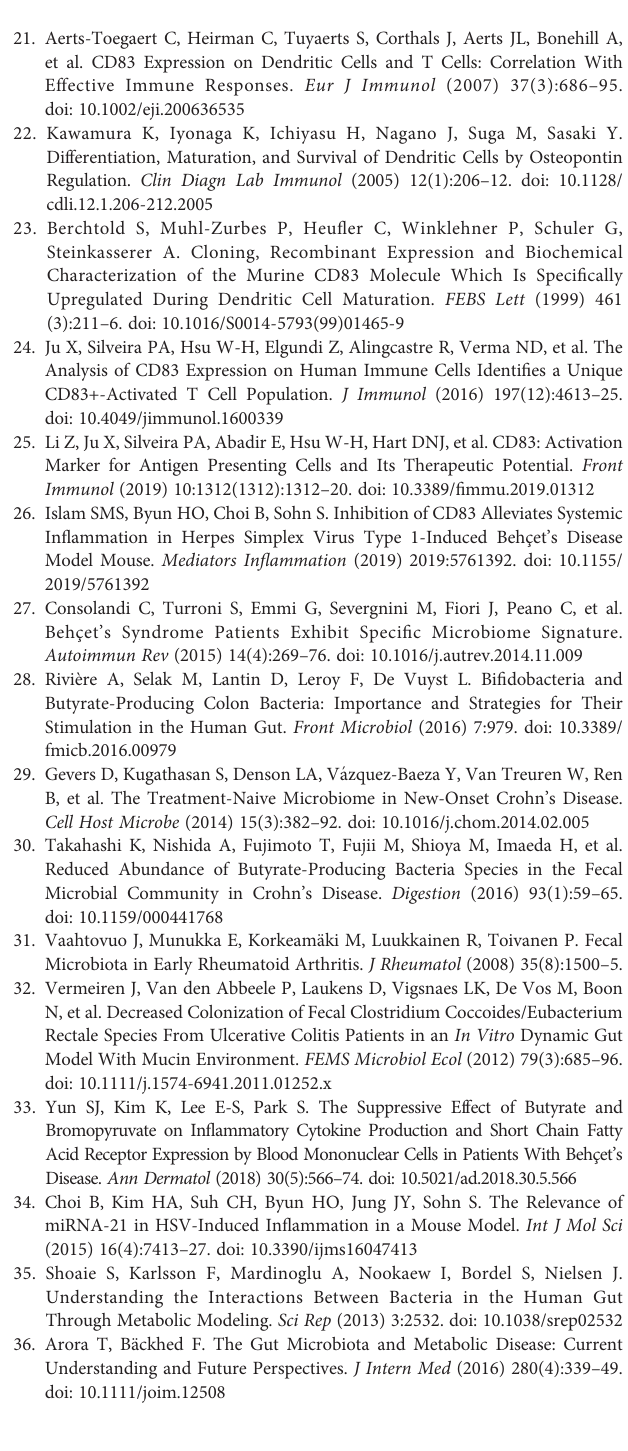
colchicine and E. rectale was analyzed by FACS (A – D) . Untreated BD mice were used as the control group. The p-value was determined by the Kruskal-Wallis test. The experiments were performed independently at least three times. Supplementary Figure 4 | The frequency of regulatory T cells in BD mice treated with E. rectale in culture solution or lyophilized E. rectale powder was analyzed by FACS (A – G) . The p-value was determined by the Kruskal-Wallis test. The experiments were performed independently at least three